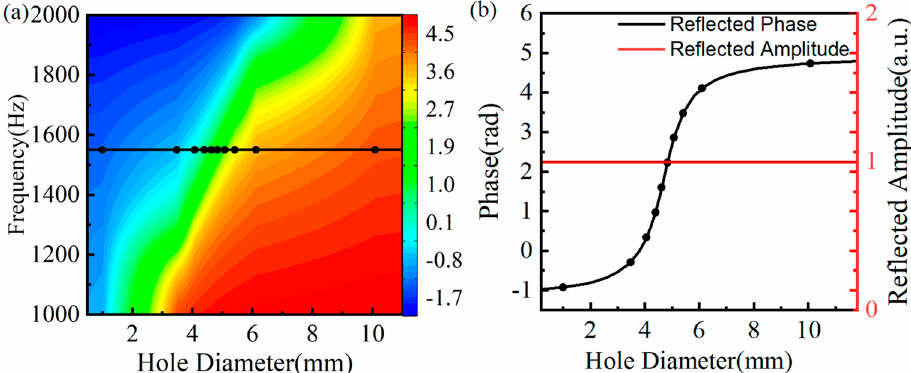
Figure 2. ( a ) The reflection phase modulation map of split hollow cuboids (SHCs) with different split hole diameters, where the corresponding frequency of the black curve is the designed center frequency; and ( b ) the reflection phase and reflection amplitude of the SHC with the different split hole diameters at the frequency of 1550 Hz, where the corresponding diameter of the black circle symbols is chosen as the split hole diameter of ten SHCs.